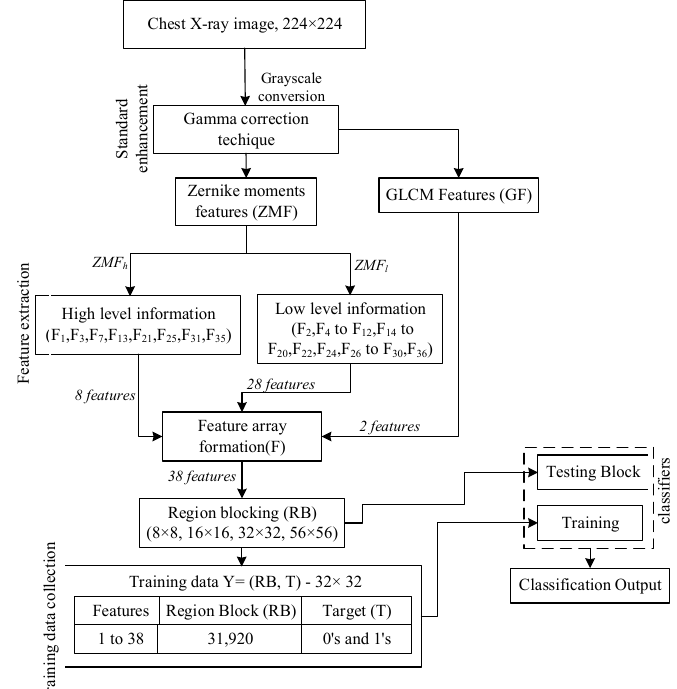
Figure 1. Block diagram of binary classification for the X ‐ ray image.